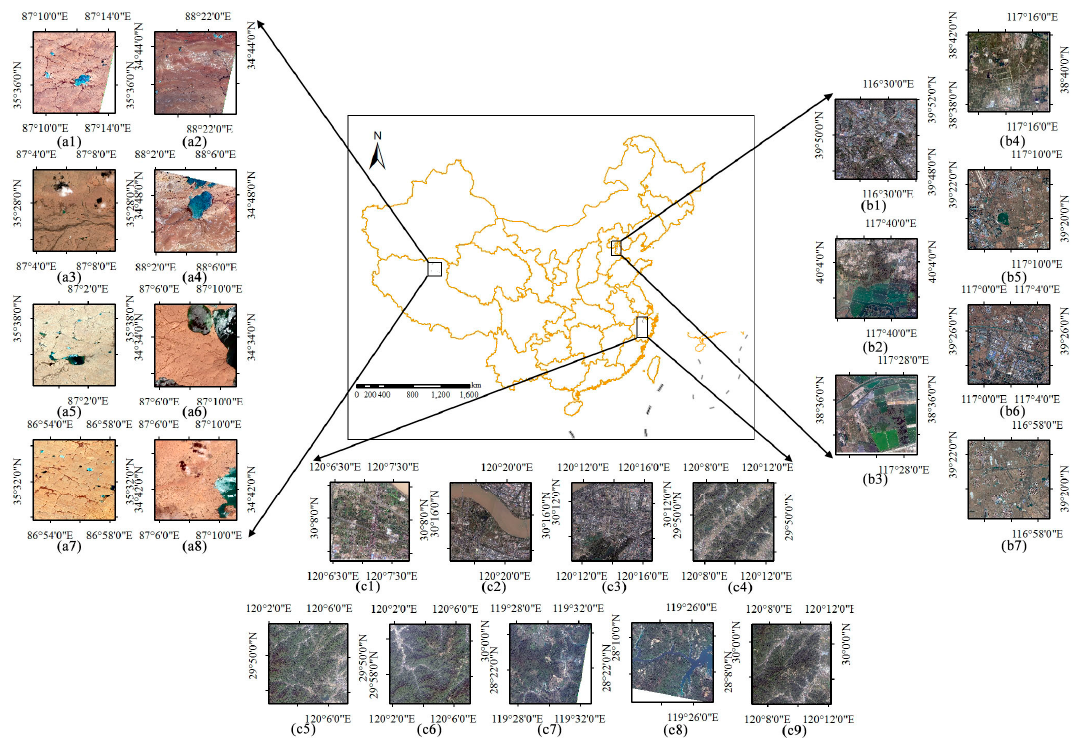
Figure 1. The GaoFen-1 (GF-1) dataset (a1, a3, a5, a6, a7, a8, b1, b2, b5, b6, b7, c1, c2, c3, c4, c5, and c6 are used for training images. a2, a4, b1, b3, b4, c7, and c8 are used for test images.). Table 1. Detailed information of dataset.